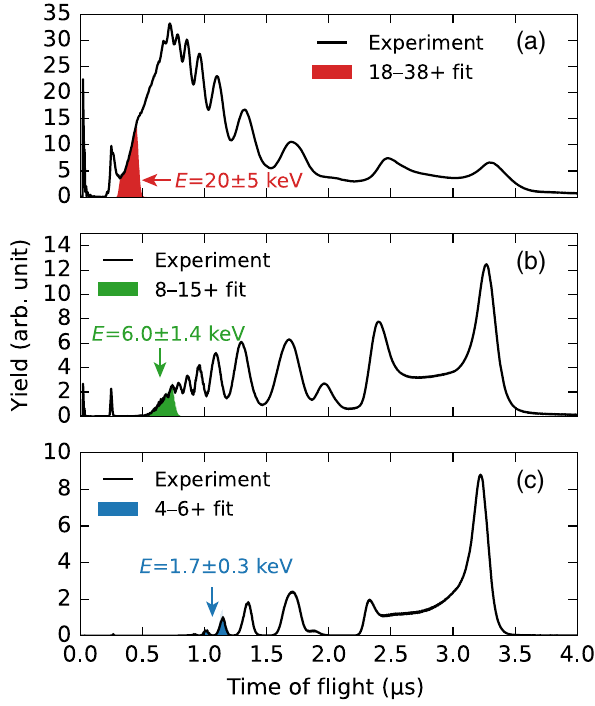
FIG. 5. Ion TOF spectra of NIR-irradiated Xe clusters at (a) I NIR ¼ 3 × 10 16 W = cm 2 , (b) I NIR ¼ 4 × 10 15 W = cm 2 , and peak peak (c) I NIR ¼ 9 × 10 14 W = cm 2 . Ion TOFs at the highest charge peak states are simulated with SIMION and fitted with the exper- imental data (for details, see Appendix